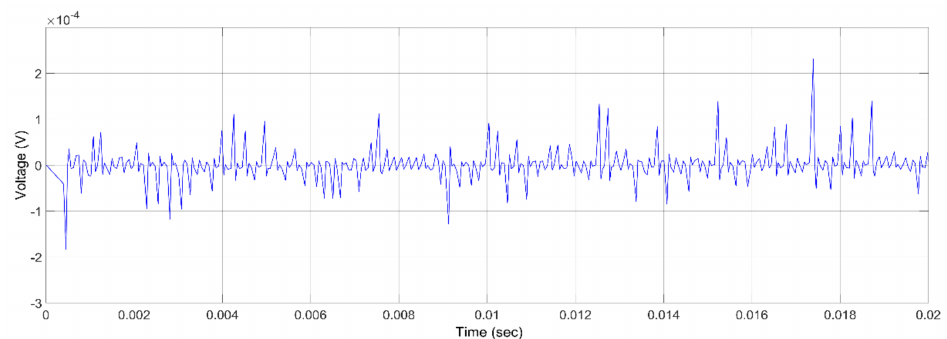
Figure 9. PD at 5 kV.